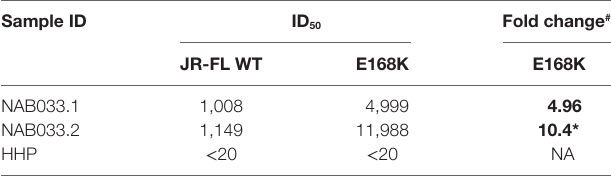
TaBle 6 | Neutralization activity against HIV-1 JR-FL WT and E168K mutant pseudoviruses.